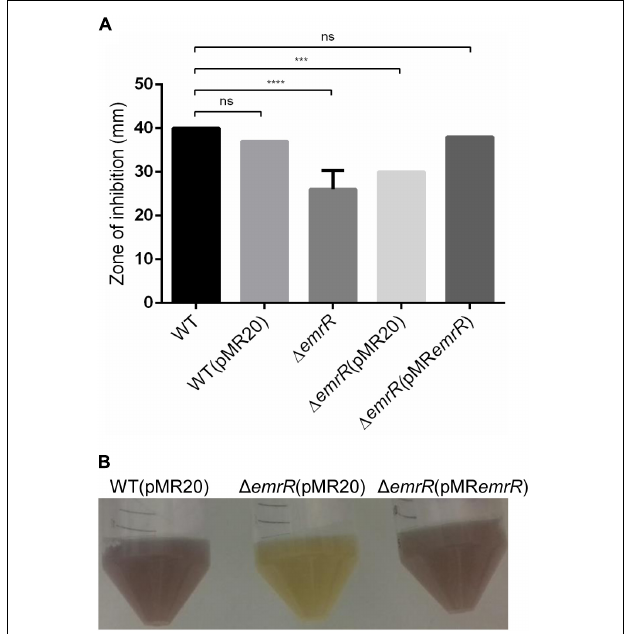
FIGURE 2 | Null deletion of emrR confers increased resistance to nalidixic acid and decreased production of violacein. (A) Disk diffusion assays for nalidixic acid performed on MH plates in biological triplicate with the indicated C. violaceum strains. The error bars indicate standard deviations. (B) Decreased production of violacein in the null mutant emrR . The indicated strains were grown in LB broth at 37 ◦ C for 24 h. P -values were determined by one-way ANOVA Tukey’s multiple comparisons test: ∗∗∗∗ P < 0.0001; ∗∗∗ P = 0.0007.